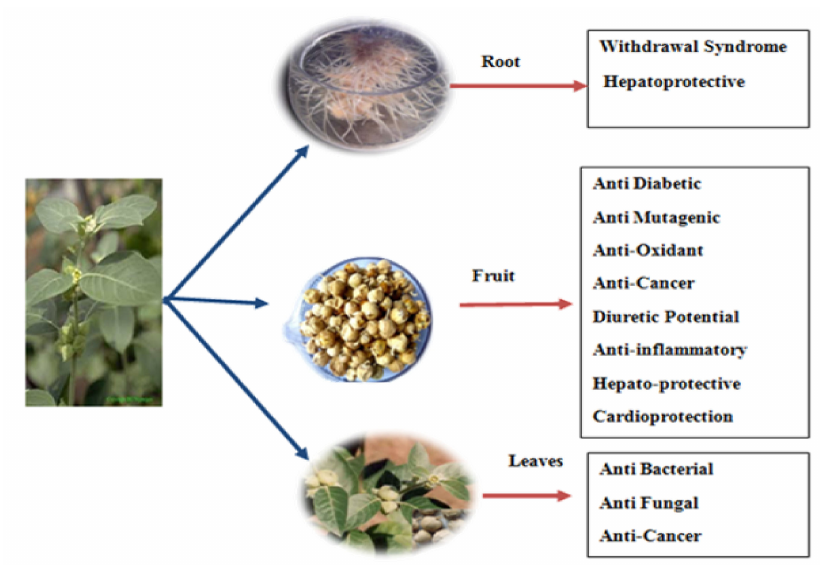
Figure 3. Graphical representation of the therapeutic potential of W. coagulans in several ailments.